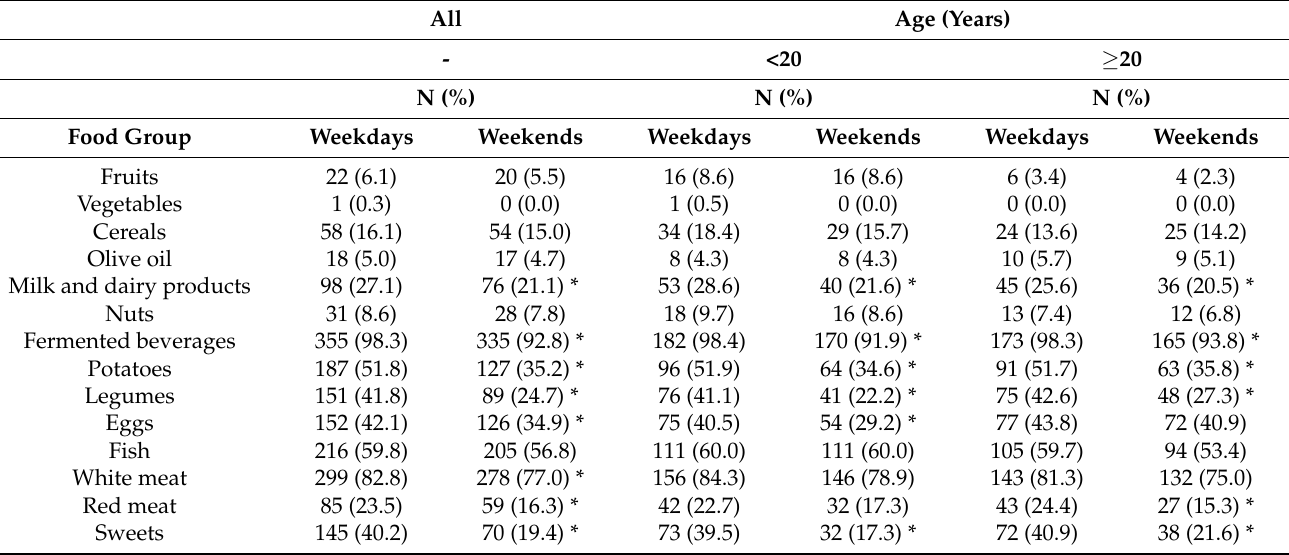
Table 7. Stratification of adherence to MD items (food groups)